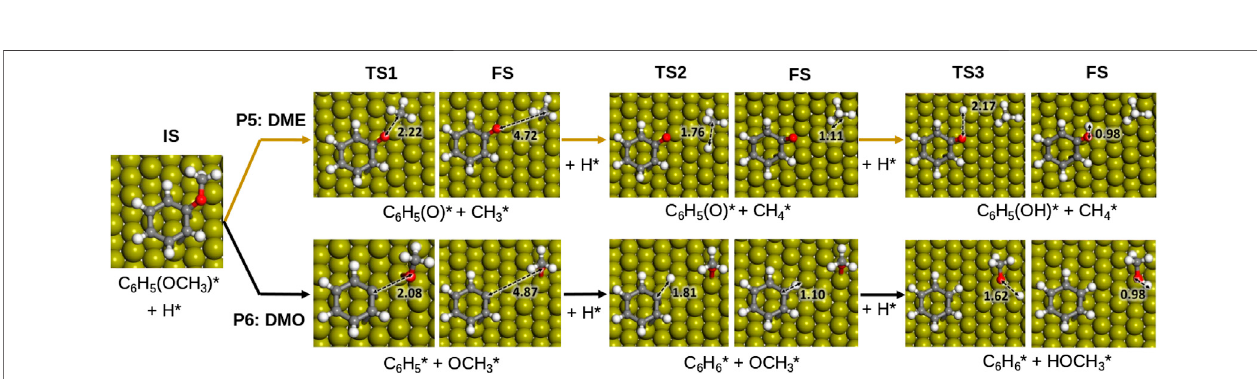
FIGURE 4 | Proposed reaction scheme for the hydrodeoxygenation of anisole on Fe (110). Colour scheme: Oxygen, red; hydrogen, white; carbon, grey and Fe, dark yellow. Inset distances are given in Å.